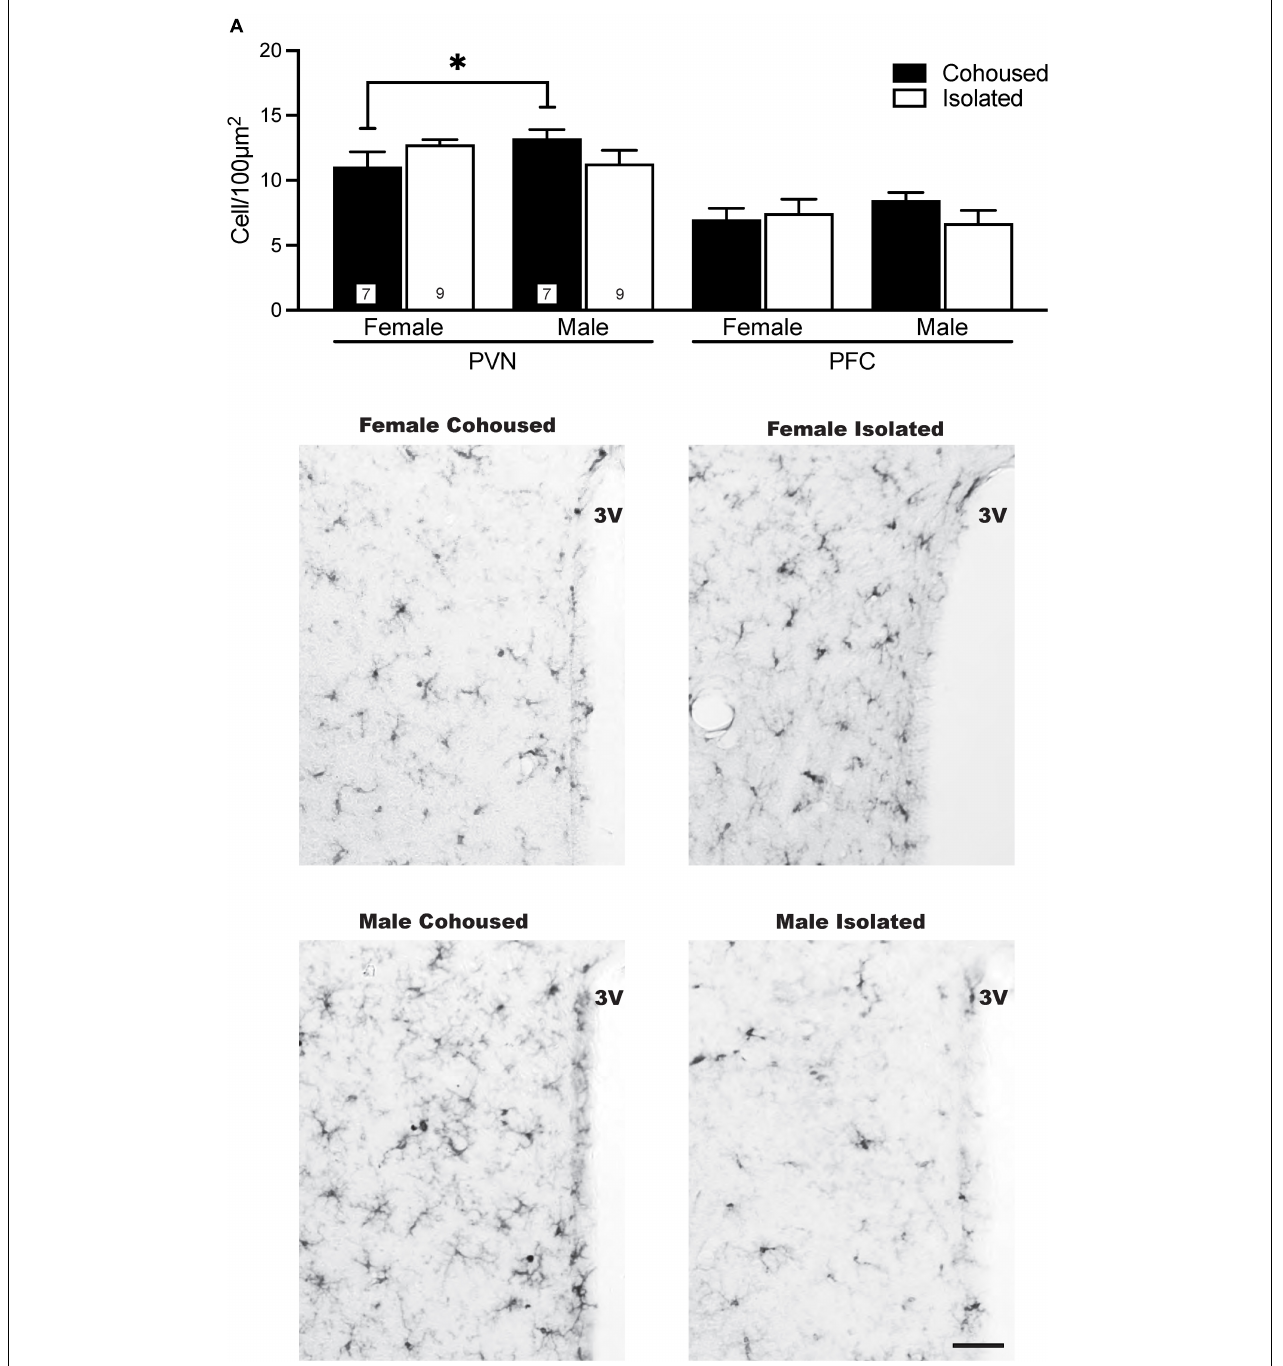
FIGURE 4 | Sex differences in ionized calcium binding adaptor molecule 1 (Iba-1) cell density in the paraventricular nucleus of the hypothalamus (PVN). Cohoused males had higher Iba-1 cell density in the PVN compared to cohoused females, but no differences were found across isolated male or female prairie voles. No group differences in Iba-1 cell density were found in the prefrontal cortex (PFC). Photomicrographs show representative images of Iba-1 labeling in the PVN. 3V, third ventricle. Bars indicate mean ± SEM. The number within each bar on (A) indicates the number of animals for each group. ∗ represents p < 0.05. Scale bar = 50 µ